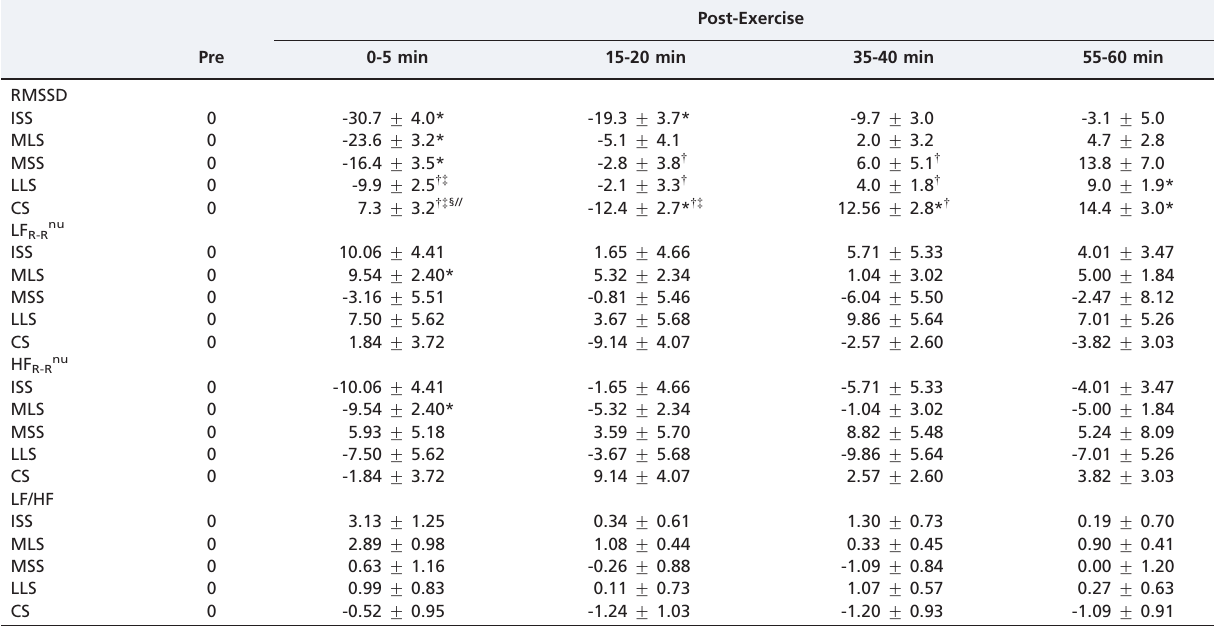
Table 4 - Variation in the indicators of autonomic